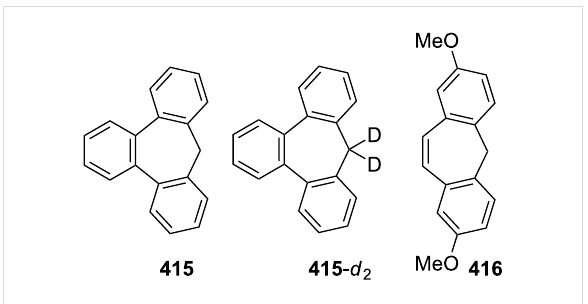
Figure 22: Reduction products 415 and 416 of tribenzotropone ( 400 ).